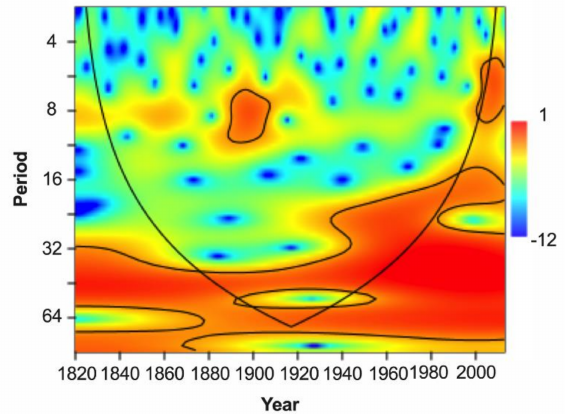
Figure 4. Wavelet power spectrum of the TRW chronology using the Morlet wavelet during the period of 1824–2016. The black line denotes the cone of influence beyond which the edge effect may distort the results. Shading with contours indicates the 95% confidence level.